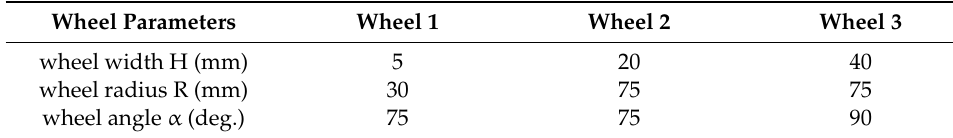
Table 1. Specification of grinding wheel.